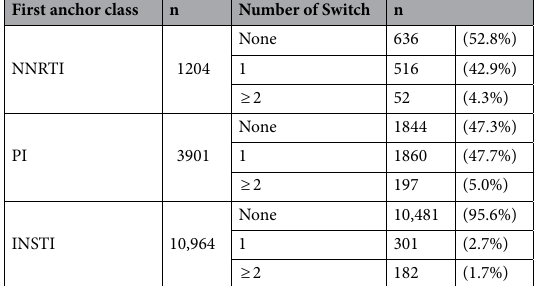
Table 1. Distribution of number of anchor class switches from 2011 to 2019 (n = 16,069). NNRTI Non- nucleoside reverse transcriptase inhibitor, PI Protease inhibitor, INSTI Integrase strand transfer